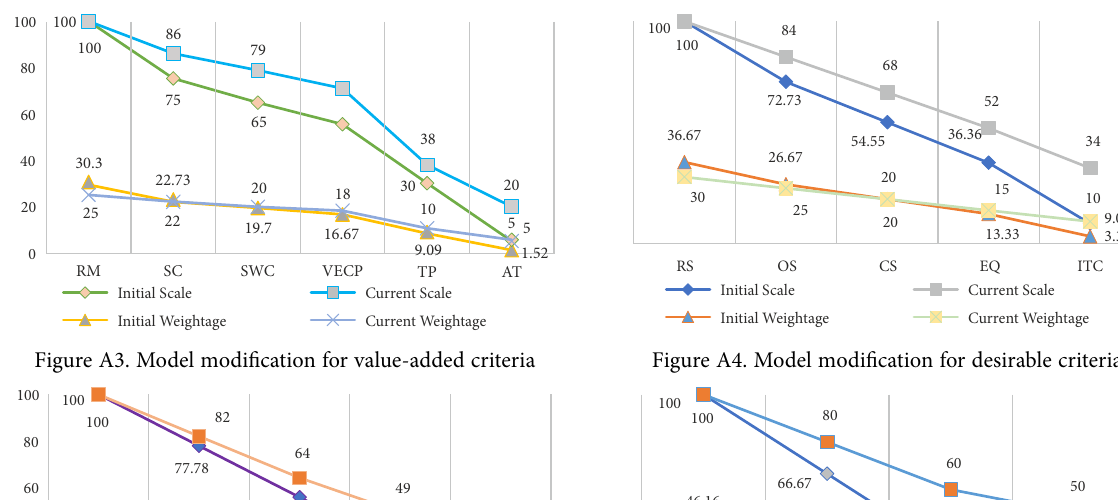
criteria category